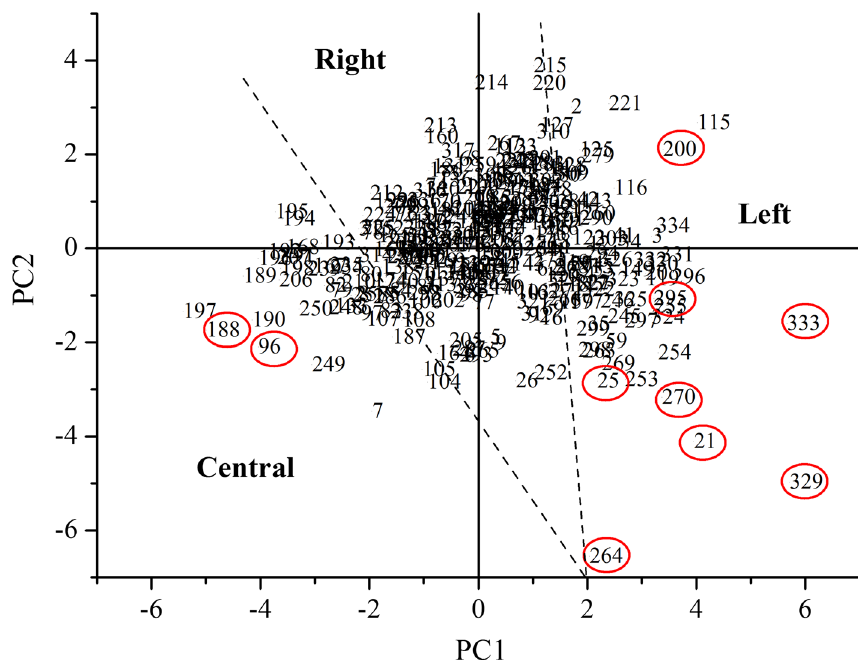
Fig. 5 PCs scatter plot of treated wastewater